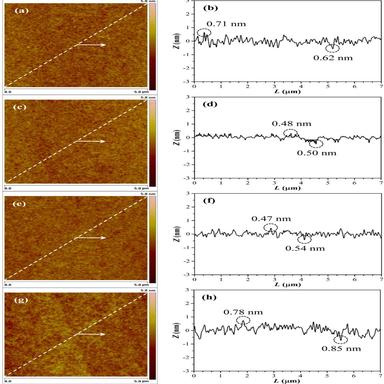
2D-AFM images and the corresponding profilograms of the surfaces CMP with (a, b) D-mSiO2-45, (c, d) D-mSiO2-60, (e, f) D-mSiO2-75, (g, h) D-mSiO2-90.